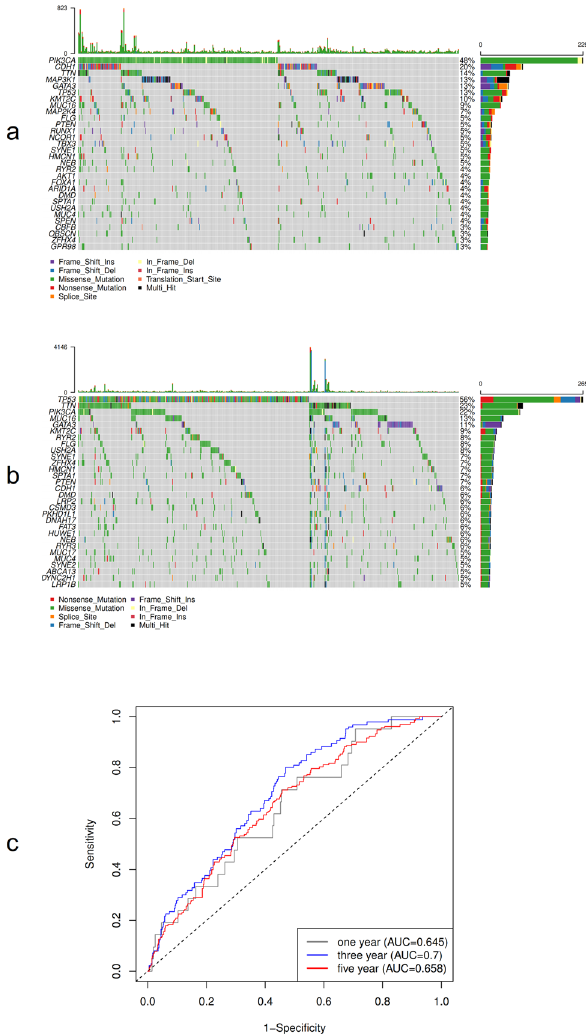
Figure 11. Molecular characteristics and prognosis of high and low ferroptosis scores. ( a ) The distribution of gene mutations in the high ferroptosis score group in the TCGA dataset; ( b ) The distribution of gene mutations in the low ferroptosis score group in the TCGA dataset; ( c ) Time-dependent ROC curve